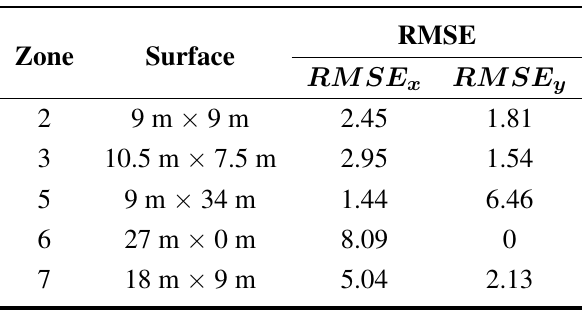
Table 10. RMSE (m) of estimation in Building